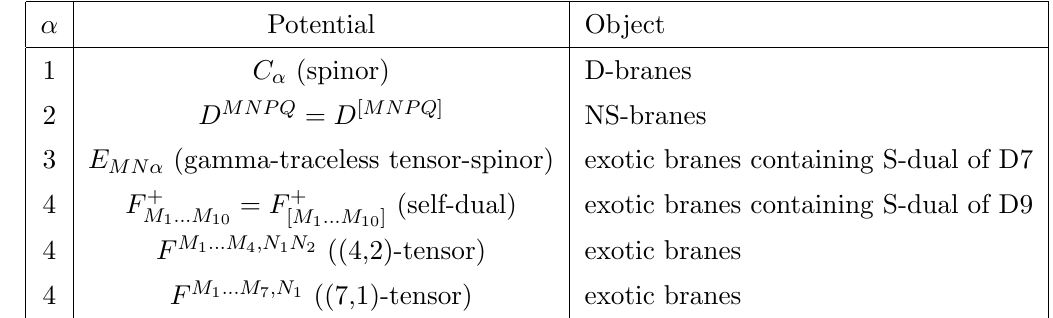
Table 1 . Double (cid:12)eld theory potentials at order g (cid:0) (cid:11)